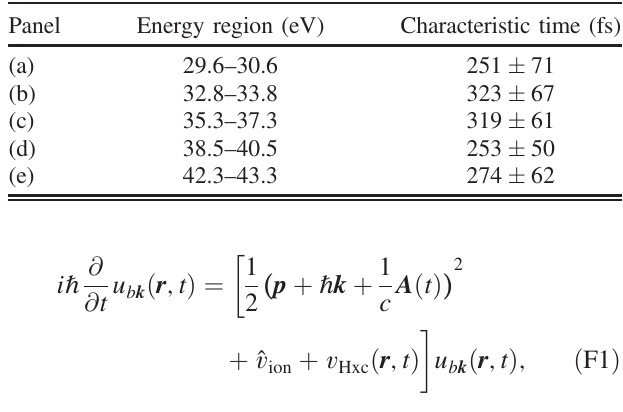
TABLE II. Fitting values of the exponential function to the individual optical density changes on the ps